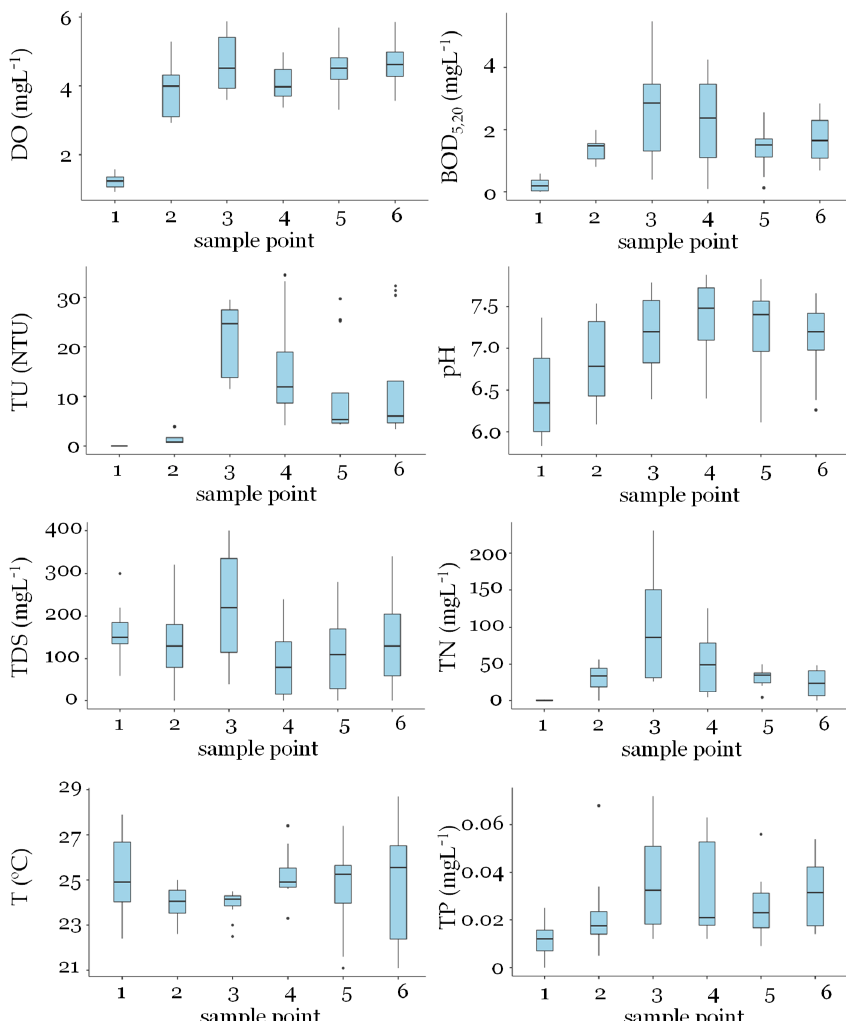
Figure 3. Physical–chemical indicators of water quality at sampling points. A significant variation of indicator parameters can be seen in Figure 3, indicating possible effects caused by the different land uses predominant in each micro-basin. Table 3 and Figure 4 present the association between land uses and water quality indicators. A two-way analysis of variance (spatiotemporal) is shown in Table 4.